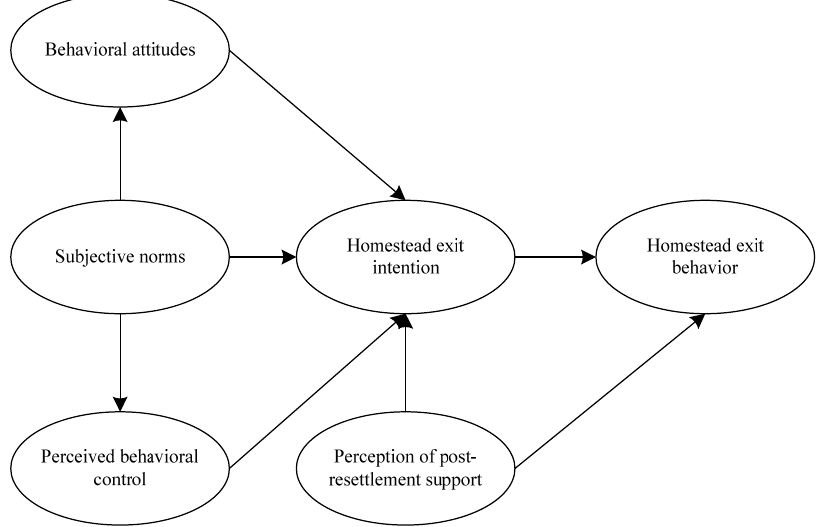
Figure 2. Theoretical model about homestead exit intention and